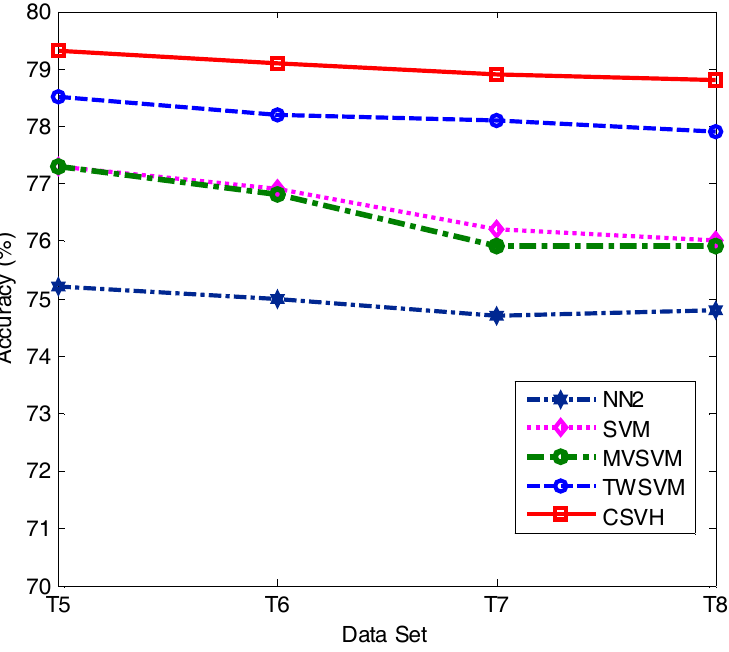
Figure 8. Classification accuracy of T5, T6, T7, and T8.